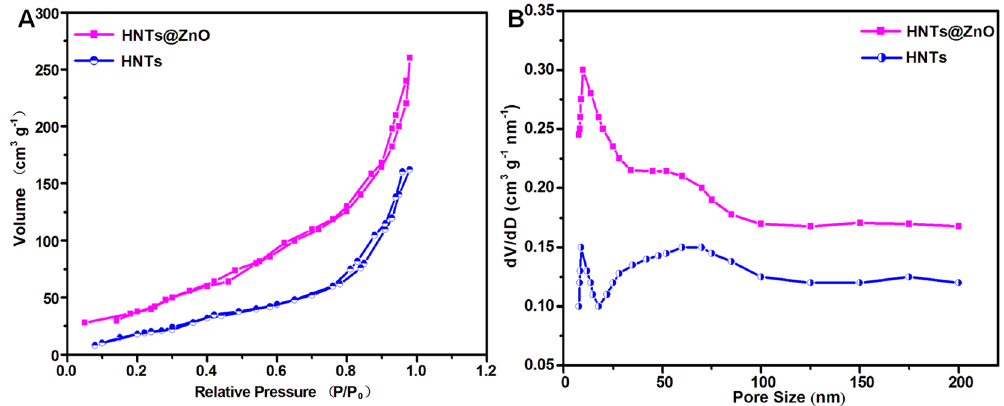
Figure 6. N 2 adsorption–desorptionisotherms and pore size distributions of ZnO@HNTs and